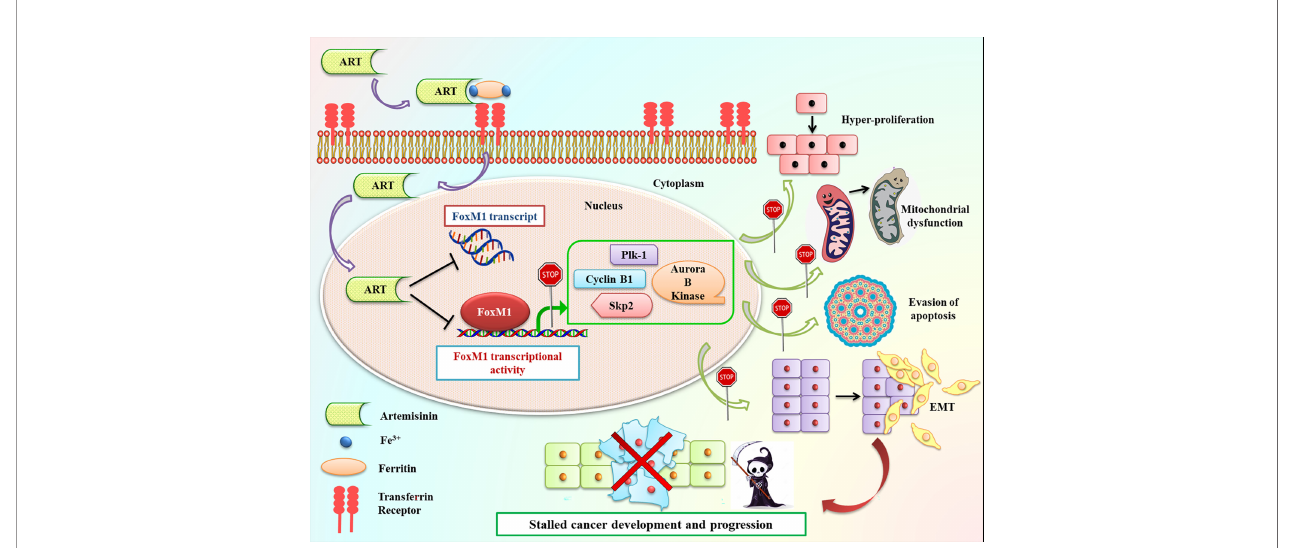
FIGURE 8 | Schematic representation of Artemisinin-mediated anticancer effects through FoxM1 repression. Following incubation of cancer cells with Artemisinin, it is taken up by the transferrin receptors present on the cell surface along with iron-loaded ferritin and transported inside the cell. Once inside the cell, we found that Artemisinin treatment transcriptionally repressed FoxM1 mRNA level and disrupted its trans -activation. The regulated expression of many of the transcriptional targets of FoxM1, such Plk1, cyclinB1, Skp2 and Aurora B kinase is necessary to prevent cell cycle deregulation, a primary hallmark of cancer. Aberrant FoxM1 transcriptional activity leads to untimely expression of these target genes, which is a common occurrence in cancers and, thereby, promotes neoplastic transformations. Artemisinin therapy blocked this perturbed transcriptional activation of FoxM1 downstream targets and led to downregulation in their expression, thus hampering various cancer hallmarks, ultimately culminating in reduced